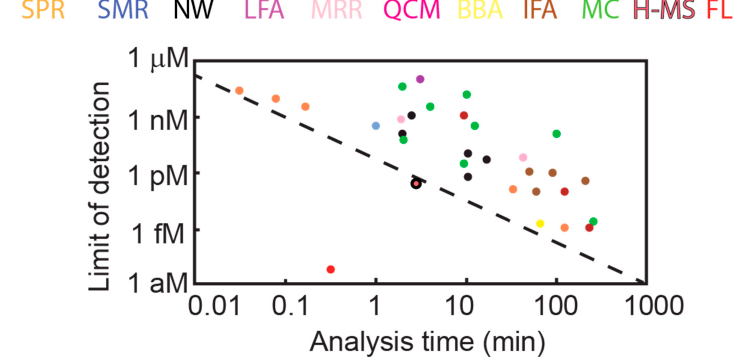
Figure 10. A comparison of biosensing techniques for protein sensing. SPR = Surface Plasmon Resonance; SMR = Suspended Microchannel Resonators; NW = Nanowires; LFA = Lateral Flow Assay; MRR = Microring Resonator; QCM = Quartz Crystal Microbalance; BBA = BioBarcode Assay; IFA = Immunofluorescence Assay; MC = Microcantilever; H-MS = Hybrid-Microsphere [18]; FL = FLOWER. The dashed line represents the present state of the art, not including recent advances in WGM sensing. For cases where the limit of detection is determined by analyte mass, a molecular weight of 34 kDa is assumed (Partially adapted from